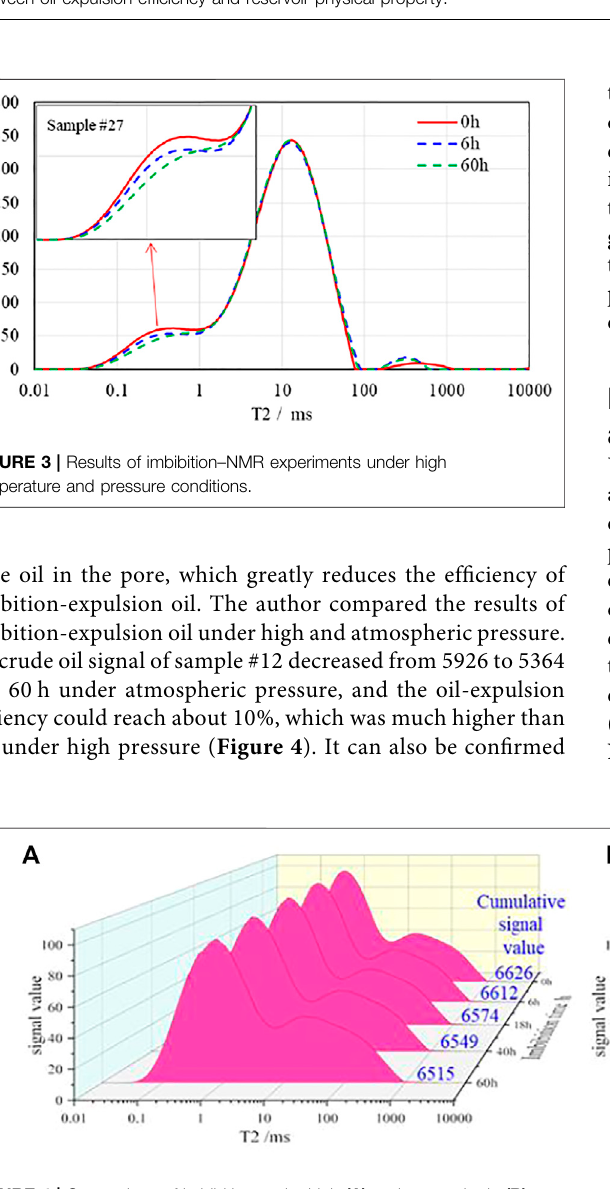
FIGURE 4 | Comparison of imbibition under high (A) and atmospheric (B)